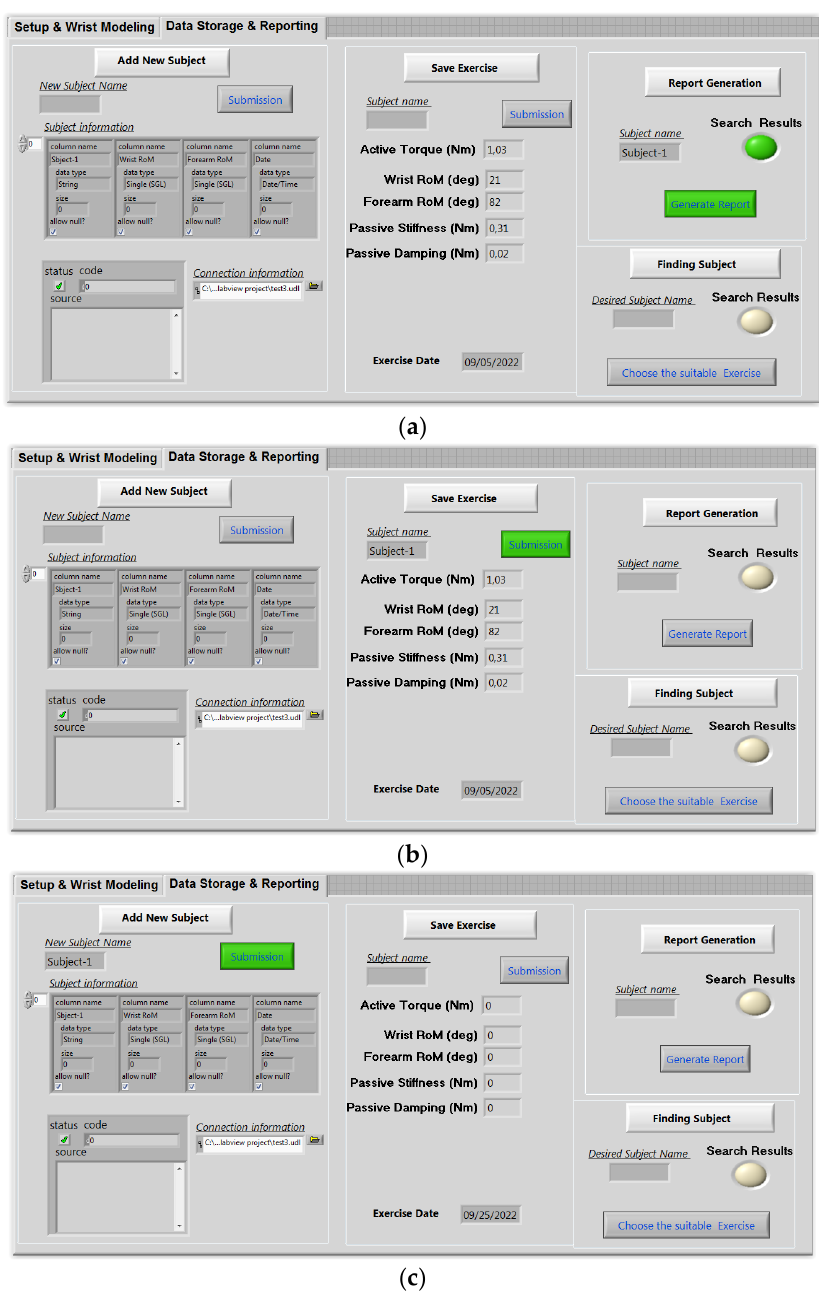
Figure 14. Data base interface: ( a ) add new subject; ( b ) save exercise; ( c ) generate report.